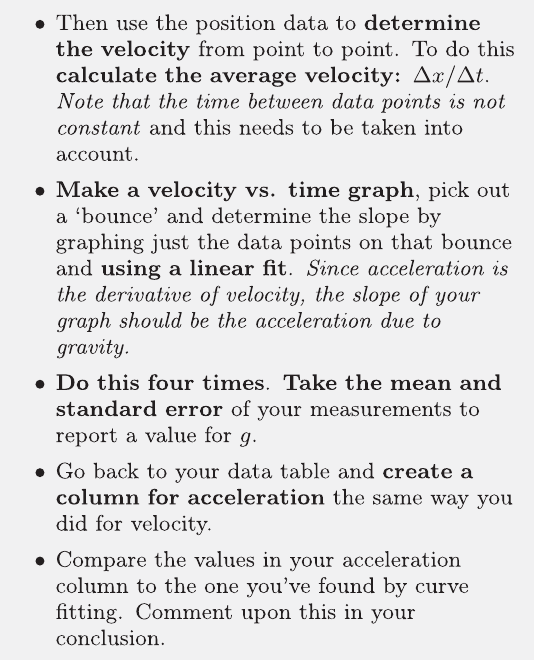
FIG. 1. Example text from a traditional lab. Bolded statement are examples of structure that limits students ’ decision making agency while italicized statements are examples of structure that limits students ’ epistemic